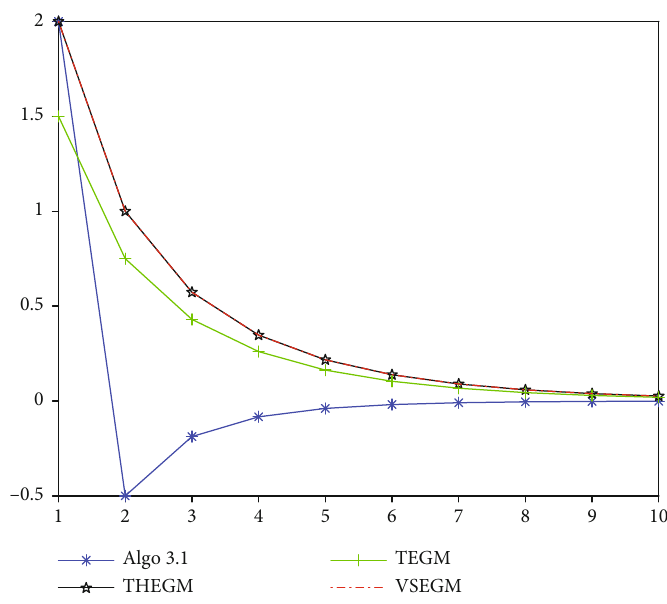
g in Example 1. n